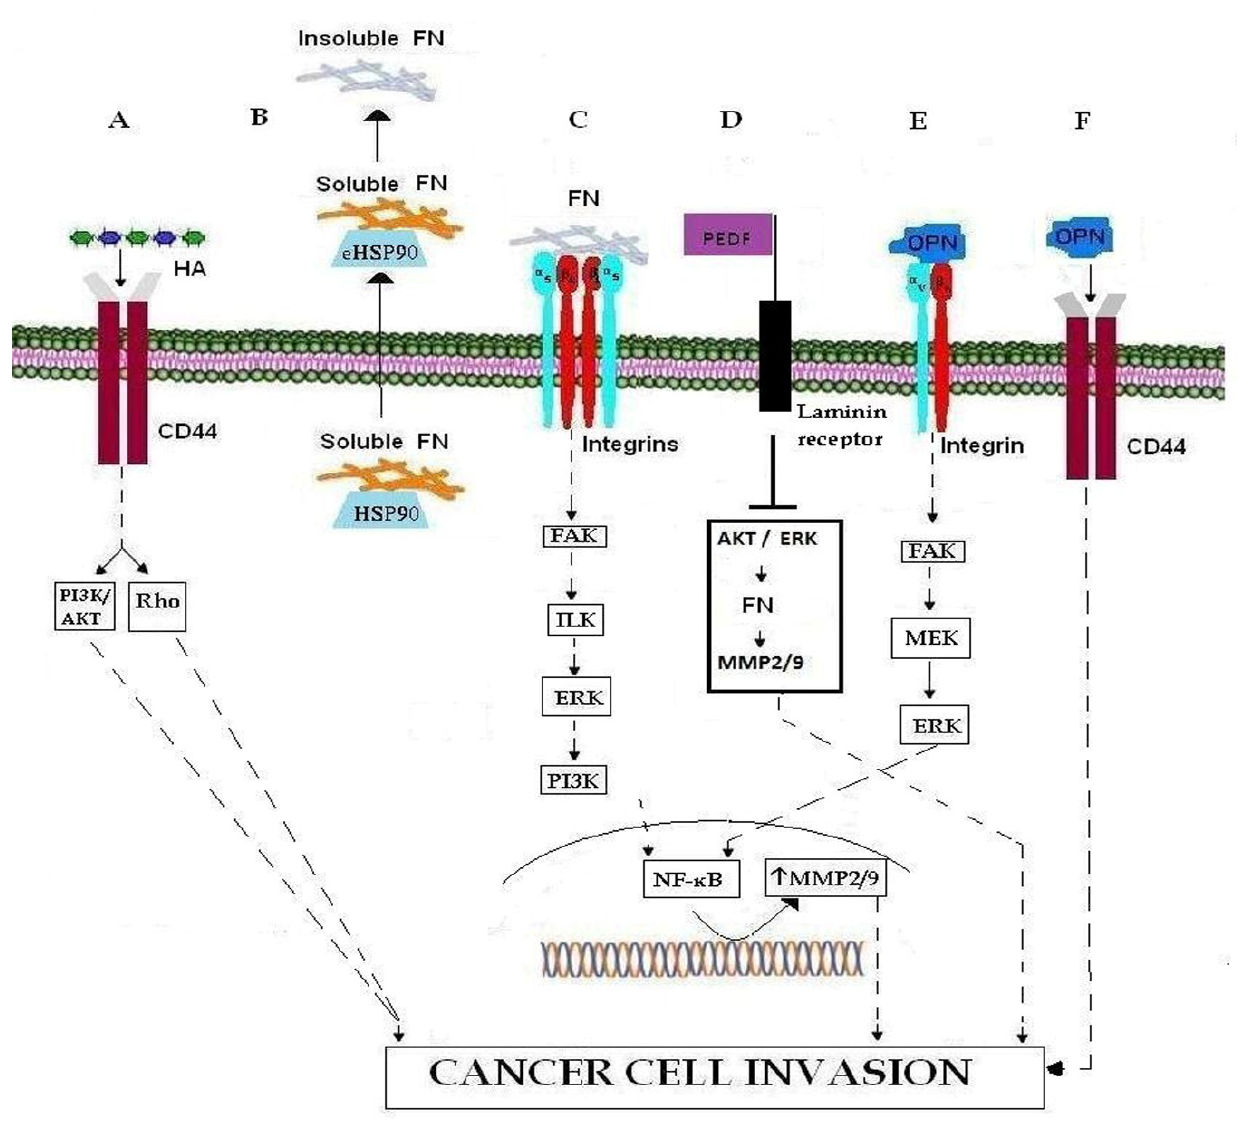
Figure 1. Important ECM molecules and ECM receptors involved in cancer cell invasion. ( A ) Binding of HA to CD44 promotes cell invasion. HA-CD44 interaction promotes invasion via the PI3Κ/AKT and Rho signaling pathways. ( B ) The transport of FN, in its soluble form, to the membrane occurs through the chaperone activity of intracellular HSP90, while eHSP90 regulates the conversion of soluble FN to its insoluble ECM form. ( C ) Binding of FN to integrin results in MMP-2 and MMP-9 over-expression via the FAK/ILK/ERK/PI3K/NF-κB pathways, and thereby leading to ECM degradation and cancer cell invasion. ( D ) PEDF binding to integrin results in MMP-2 and MMP-9 down-regulation through inhibition of AKT/ERK signaling pathway. ( E ) OPN binding to integrin promotes cancer cell invasion by inducing MMP-9 over-expression through the FAK/MEK/ERK/NF-κB pathway. ( F ) Binding of OPN to CD44 promotes cell